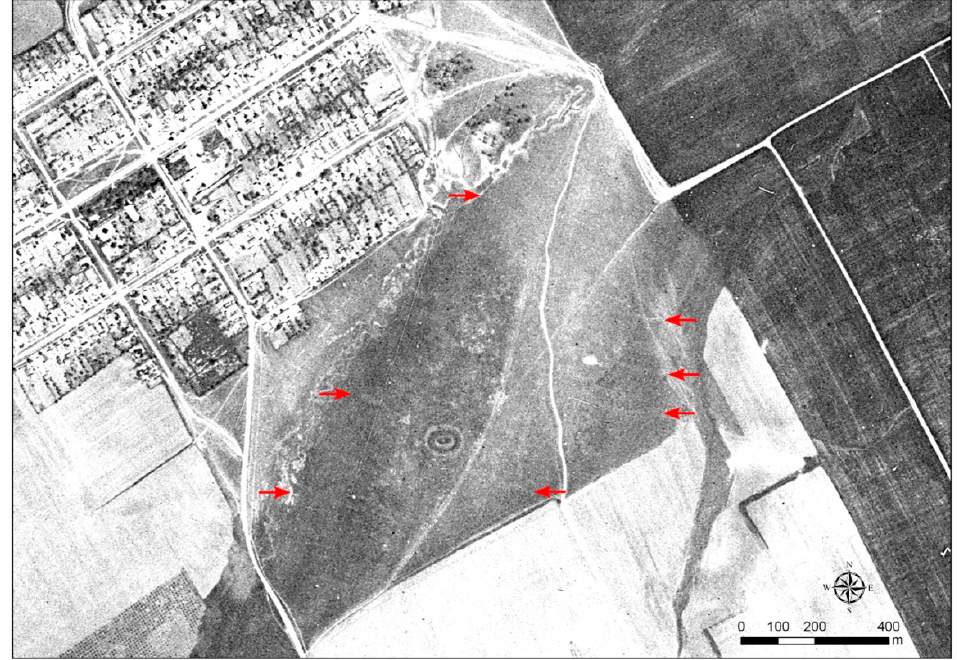
Figure 13. Georeferenced 20.05.1964 Corona spy satellite image DZB00400800010H024001_a. Red arrows indicate the presumed field-system visible as a cropmark. No sign of ploughing at that time, indicating the entire area of the medieval village was pastureland for the modern Ma ș loc village.